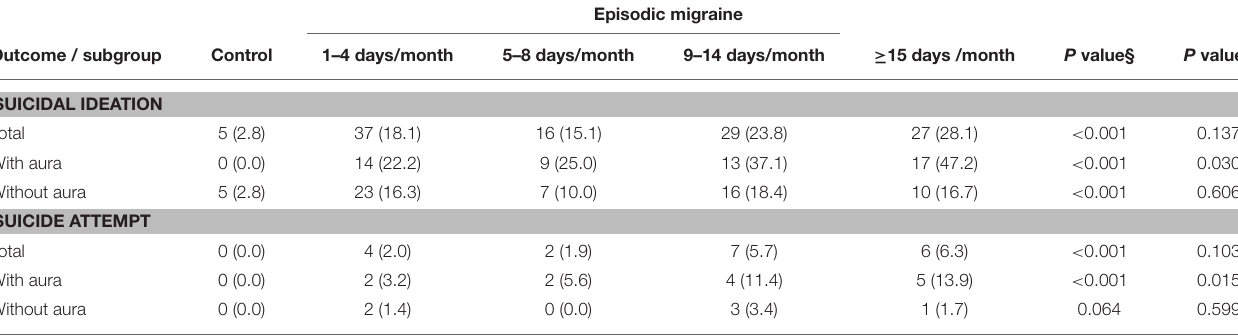
TABLE 2 | Prevalence of suicidal ideation and suicide attempts in the control and migraine